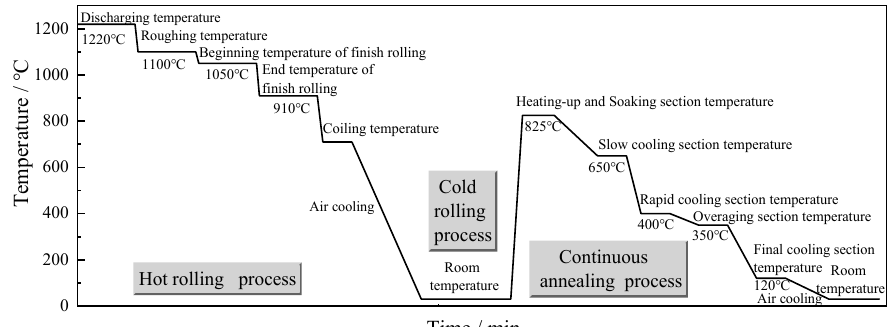
Figure 2. The specific technological process of each rolling process.